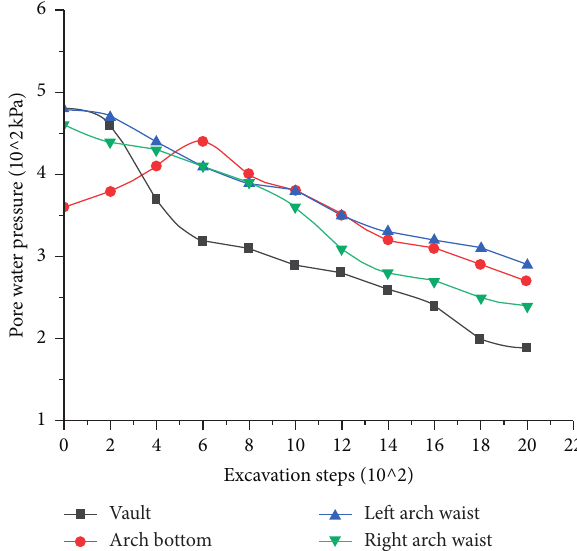
Figure 4: Change curve of pore water pressure.